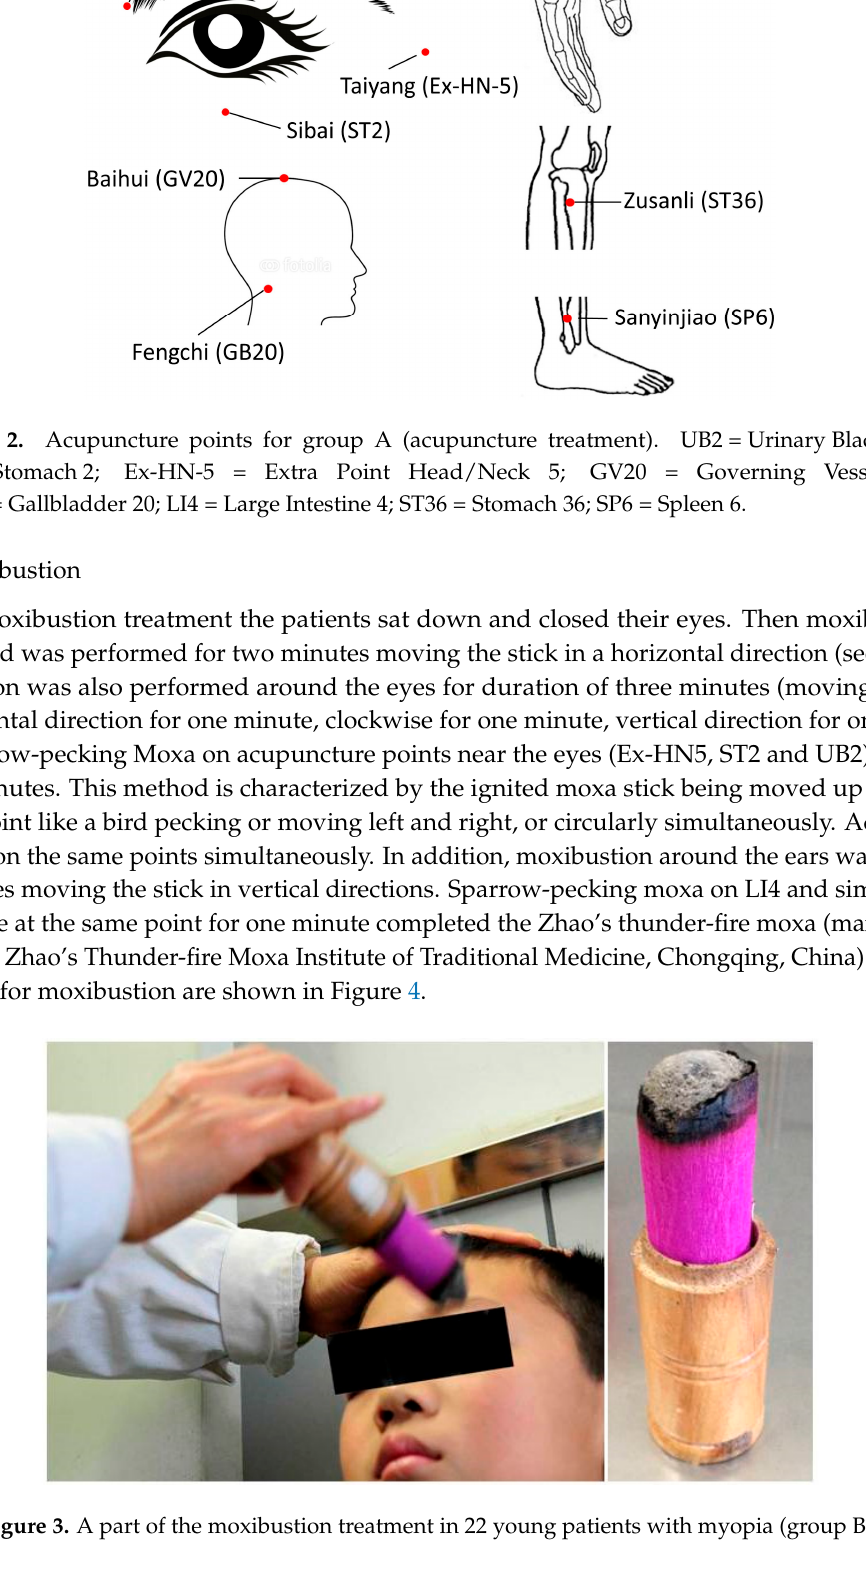
Figure 4. Points for group B (moxibustion treatment). UB2 = Urinary Bladder 2; Ex-HN-5 = Extra Point Head/Neck 5; ST2 = Stomach 2; LI4 = Large Intestine 4. 2.3. Evaluation Parameters Axial lengths were observed before and after treatment with acupuncture or moxibustion. The diopters of the right (OD) and left (OS) eye were evaluated before and after the two treatment methods by a blinded assessor (medical doctor from Tongren Hospital). Compound tropicamide eye drops (0.5% tropicamide, 0.5% phenylephrine hydrochloride) were used before and after the last treatment session. 2.4. Statistical Analysis The statistical analysis was carried out with the computer program SigmaPlot 14.0 (Systat Software, Chicago, IL, USA). Kruskal-Wallis One Way Analysis of Variance (ANOVA) on Ranks for group analysis and box plot analysis was used. In addition, paired t-tests before and after the treatments were carried out. The level of significance was set at p < 0.05. The original data can be found at the Department of Traditional Chinese Medicine & Acupuncture, Tongren Hospital affiliated to Capital Medical University, 100730 Beijing, China and at the TCM Research Center Graz, Medical University of Graz, 8036 Graz, Austria. 3. Results All 44 patients finished at least five treatment session (mean sessions: 8.0 ± 1.8 (range: 5–10 treatments)). Due to time reasons, treatment in the children in Beijing was only possible during holiday time. Group analysis of the demographic data showed no statistical difference in age, sex, height, and weight. Acupuncture and moxibustion were accepted well and there were no side effects monitored by the medical doctors of the Tongren Hospital in any of the children. Table 2 demonstrates the mean ± SD of OD and OS from all patients and each from both groups (A and B) respectively.